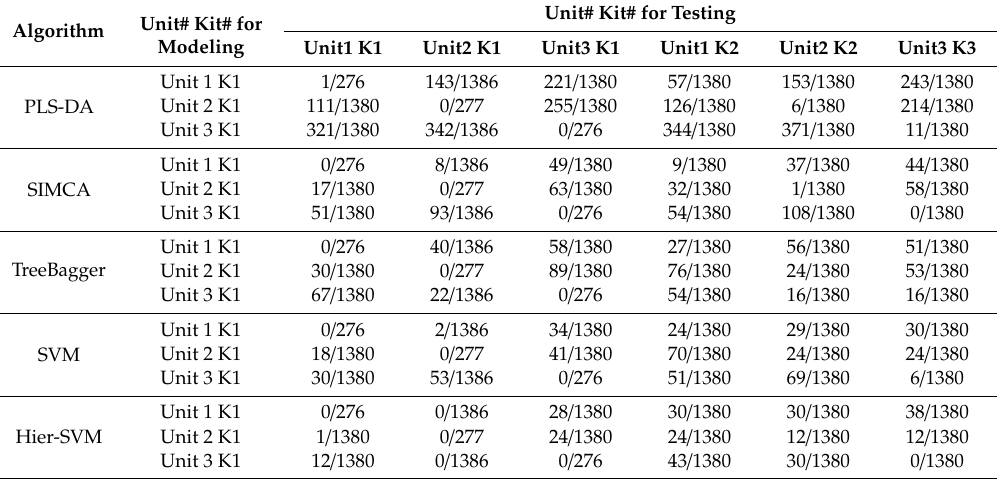
Table 2. Number of missed predictions of polymer classification in the format of number of missed predictions / total number of